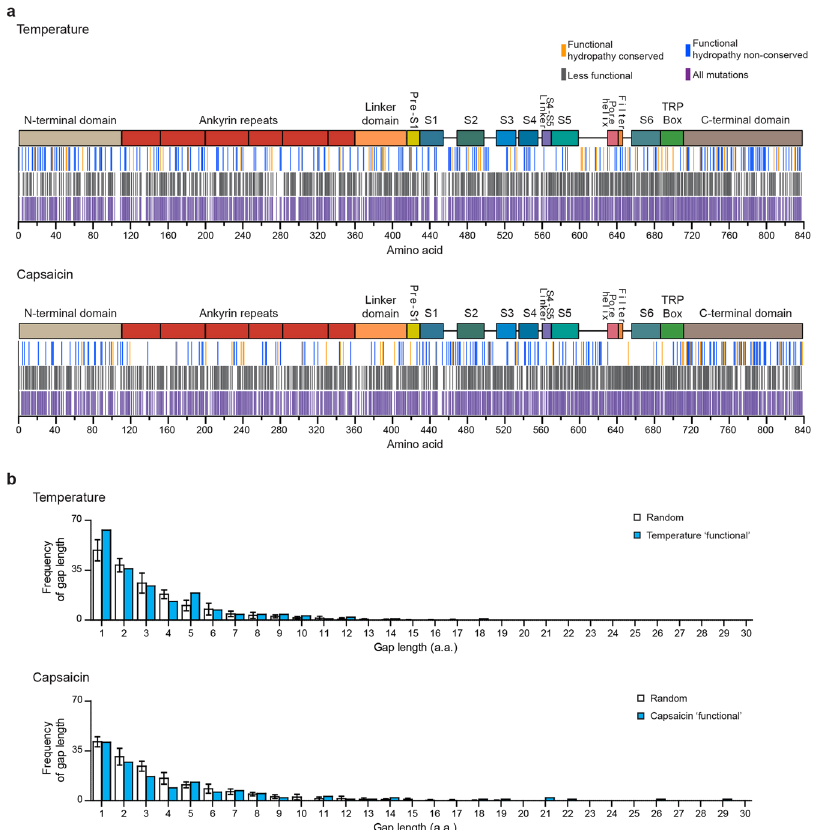
Figure 3. Location of identified mutations. ( a ) Illustration of the location of identified mutations screened with temperature (top panel) or capsaicin (bottom panel) for ‘functional’ clones (blue and yellow), ‘less functional’ clones (gray) or all identified mutations pooled together (purple). In yellow are ‘functional’ mutations that conserved wild-type amino acid hydropathy. In blue are ‘functional’ mutations that did not conserve amino acid hydropathy. Mutations were considered hydropathy-conserving if the Δ hydropathy (hydropathy mutant − hydropathy WT ) = ± 0.6. Mutations outside of that range are considered non-conserving. Each bar indicates one single mutation and boxes on top illustrate the structural domains of TRPV1. ( b ) Histogram of frequencies of gap lengths between mutations of temperature (top) or capsaicin (bottom) ‘functional’ category and gap lengths within ten random distributions of 287 (temperature, top) or 248 (capsaicin, bottom) mutations in 838 positions. Error bars are